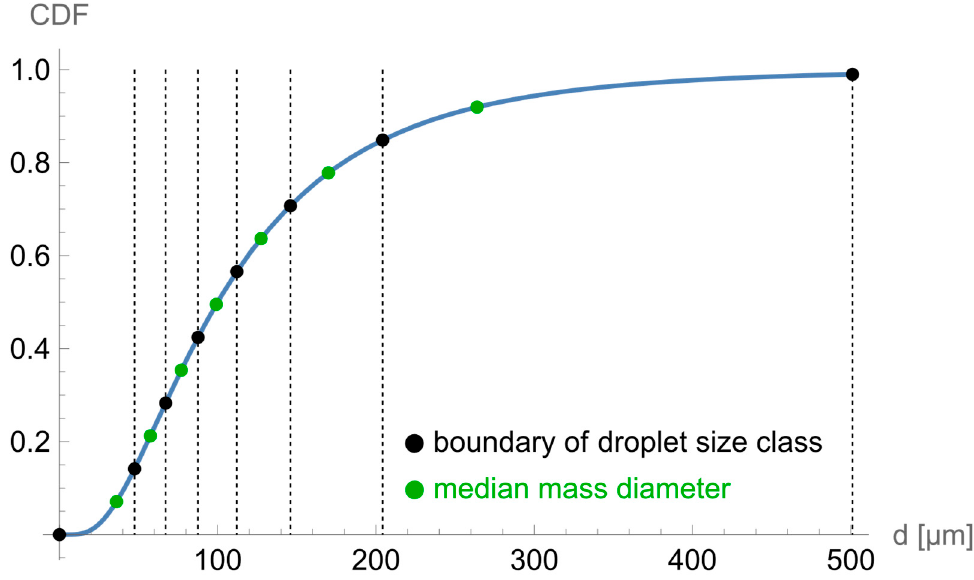
Figure 2. CDF of a cumulative mass